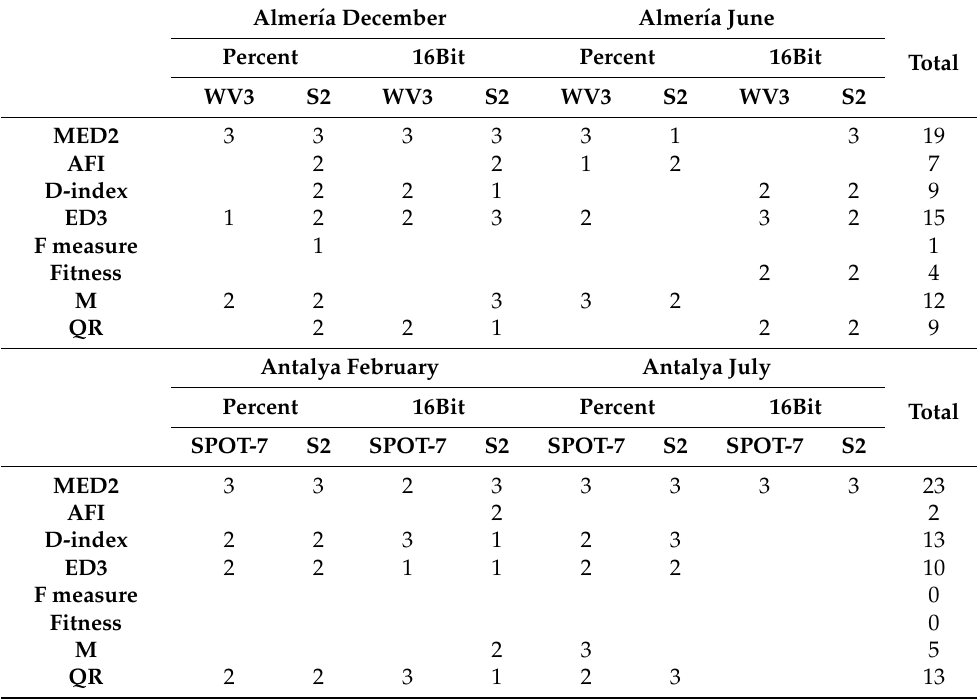
Table 4. Overall scores (points granted by experienced interpreters) of each one of the tested metrics given by the sum of the scores of all segmentation data sets in Almer í a and